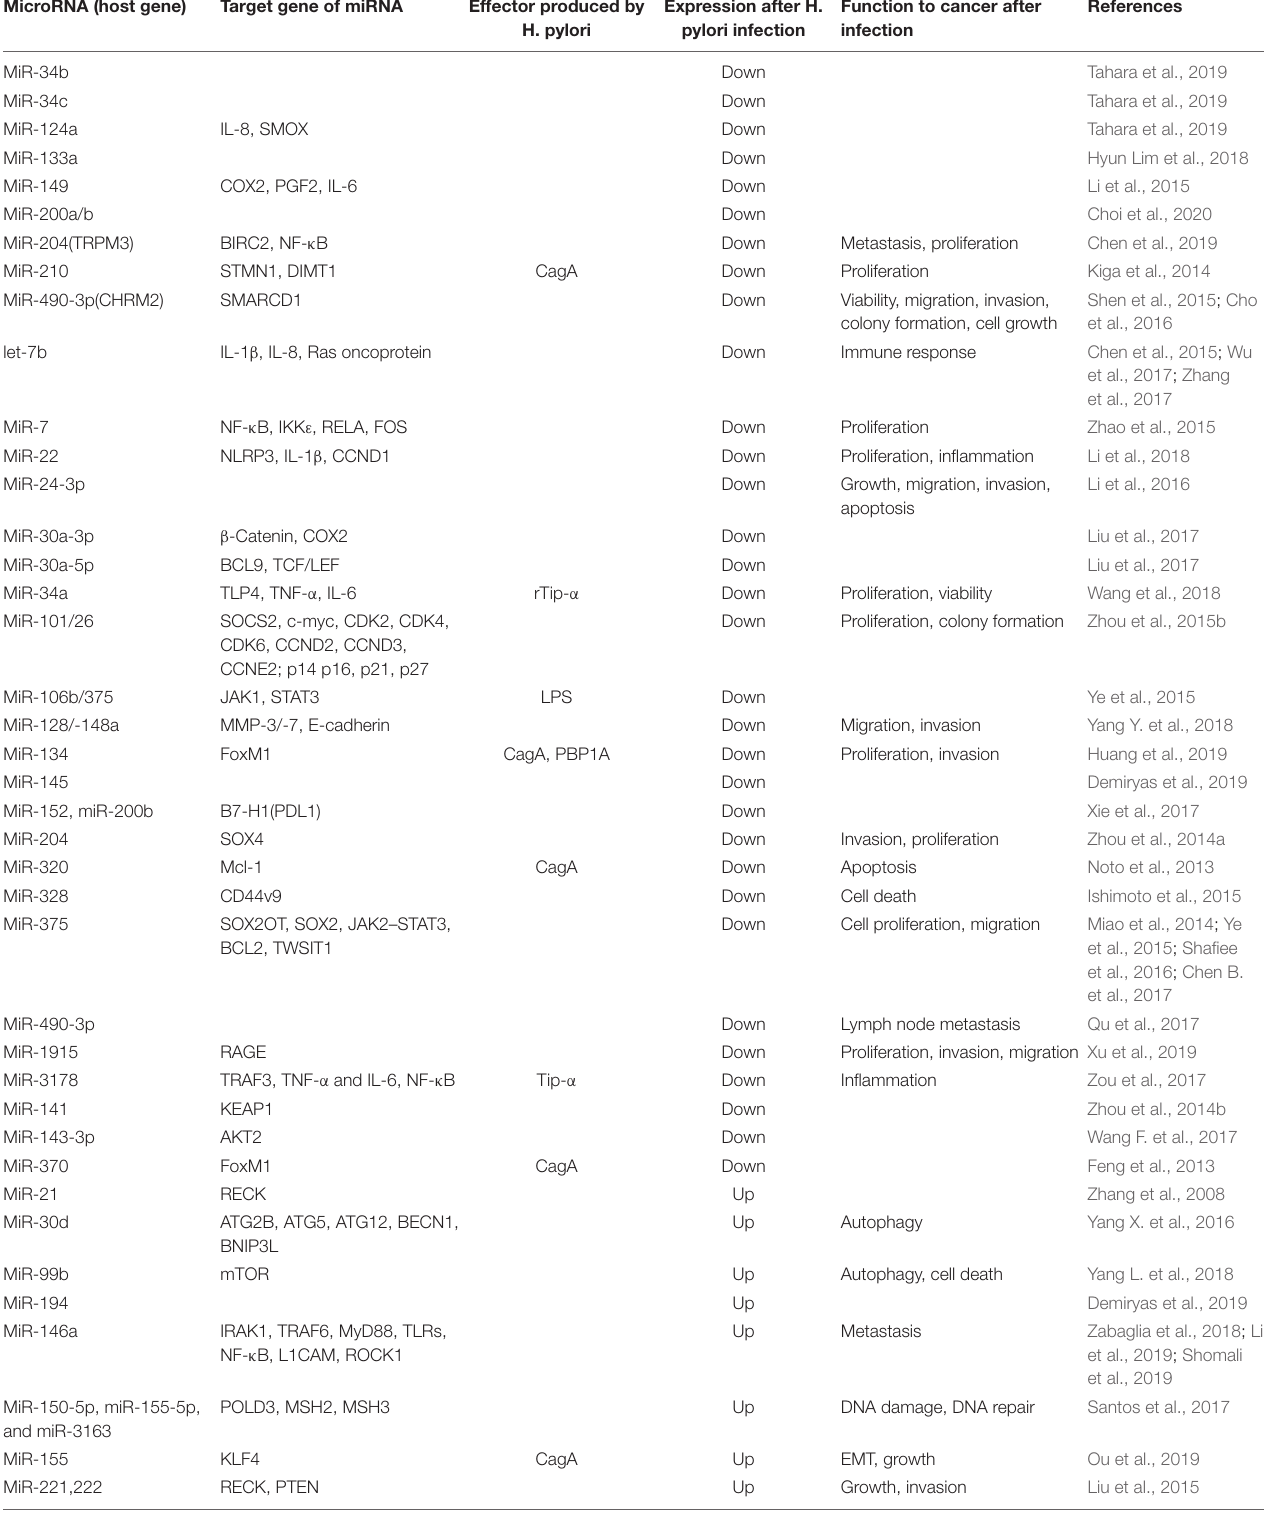
TABLE 2 | Function of miRNA in Helicobacter pylori-infected gastric cancer. MicroRNA (host